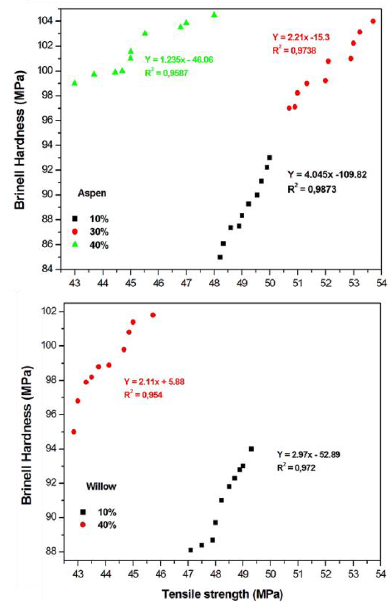
Figure 7. The correlation between Brinell hardness and tensile strength of the biocomposite reinforced with aspen and willow wood